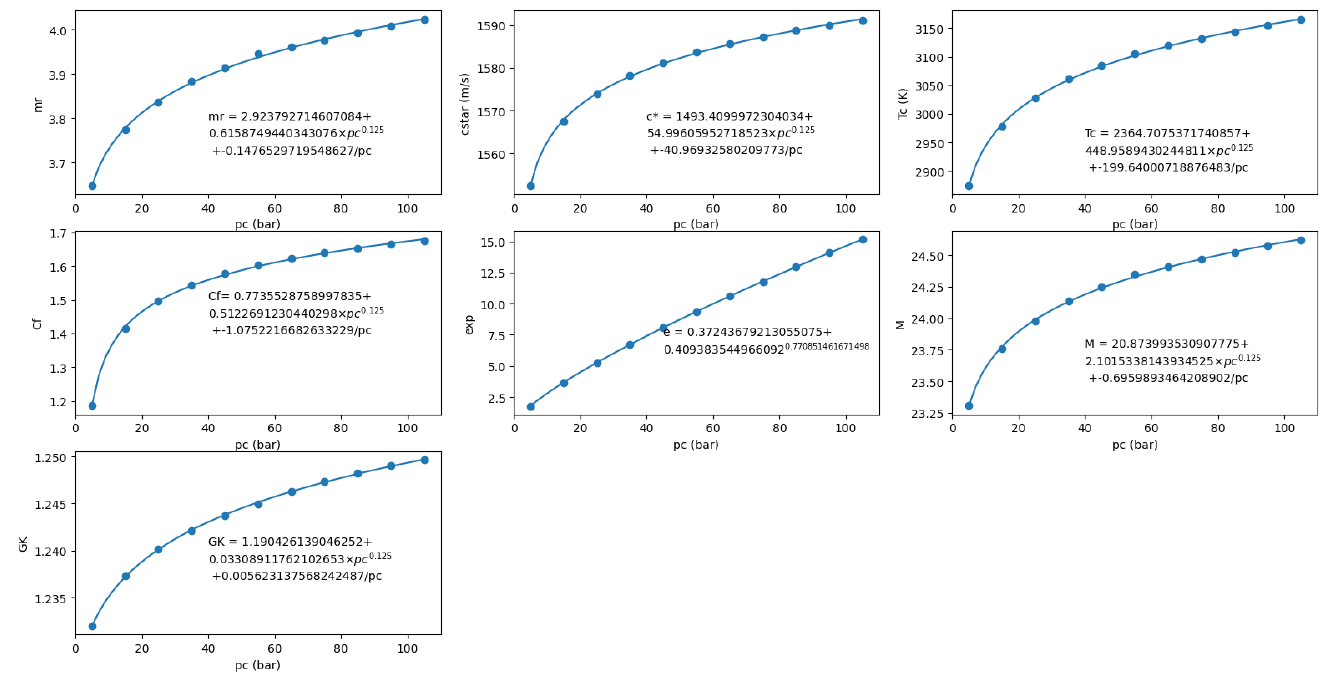
Figure A1. Curve-Fitting Results for RFNA-RP1 at 0.7 bar p e